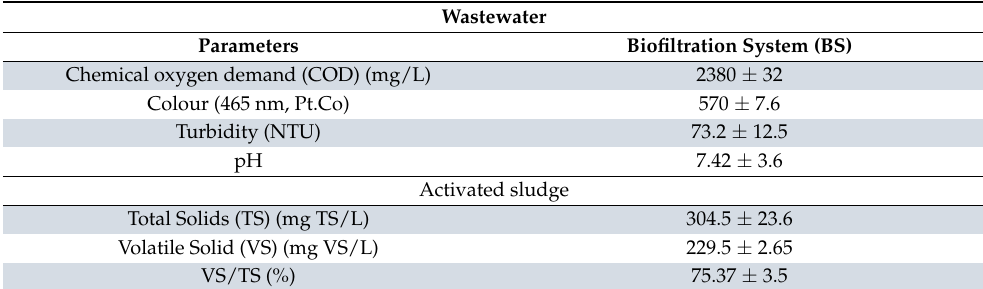
Table 1. Characterization of wastewater and activated sludge